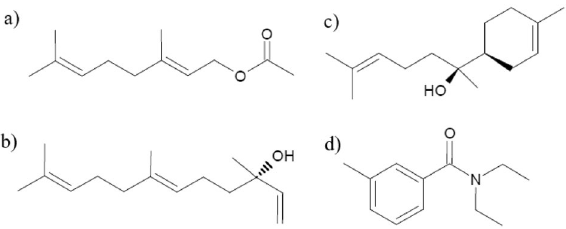
Figure 1. Molecules with repellent activity implemented in the electroantennography and proteomic assays ( a ) Geranyl acetate, ( b ) Nerolidol, ( c ) α-bisabolol, ( d )